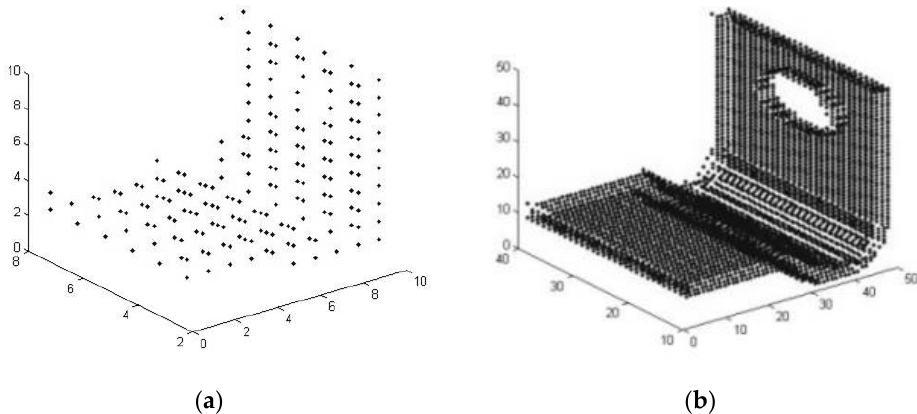
Figure 6. The results of using different sampling numbers. ( a ) N is 10; ( b ) N is 50.